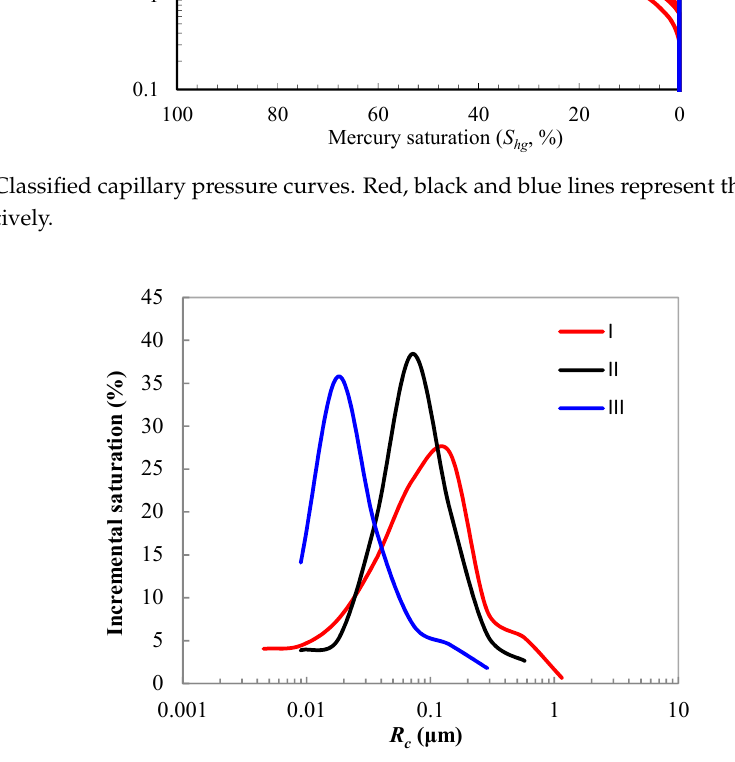
Figure 4. Average pore size distributions for the three types. Red, black and blue lines represent the types I, II and III, respectively.